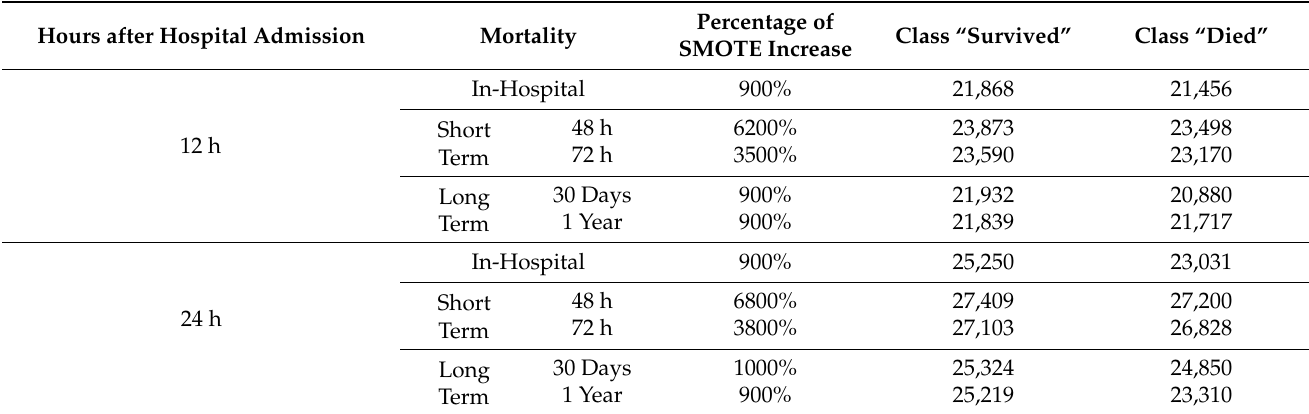
Table 4. Number of instances increased by SMOTE